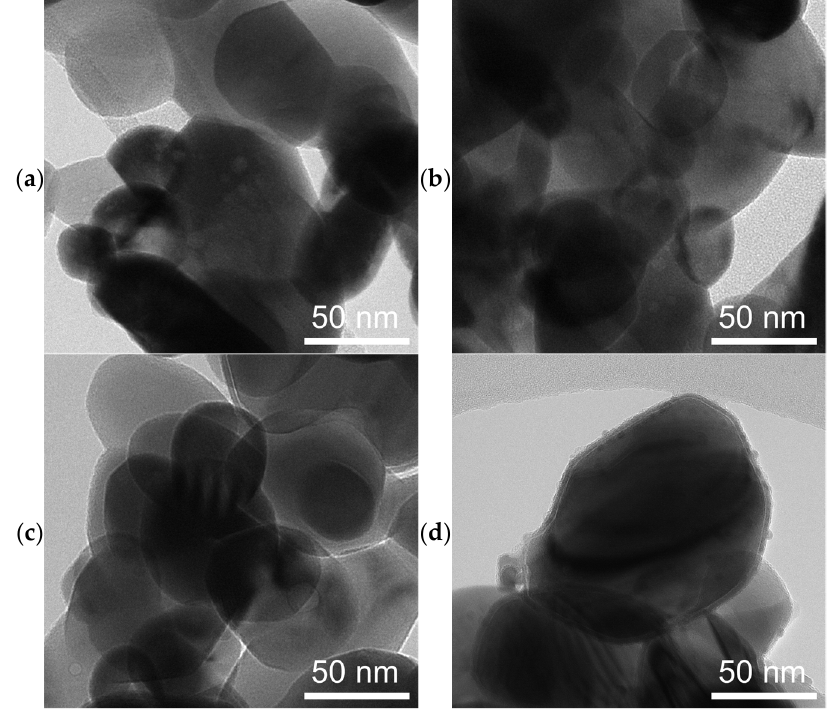
Figure 4. TEM images of spent catalysts after CO 2 hydrogenation of ( a ) FeO x , ( b ) 1% Cu/FeO x , ( c ) 3% Cu/FeO x , and ( d ) 5% Cu/FeO x showing the transformation of the rod-like particles of the fresh catalysts into roughly spherical particles.